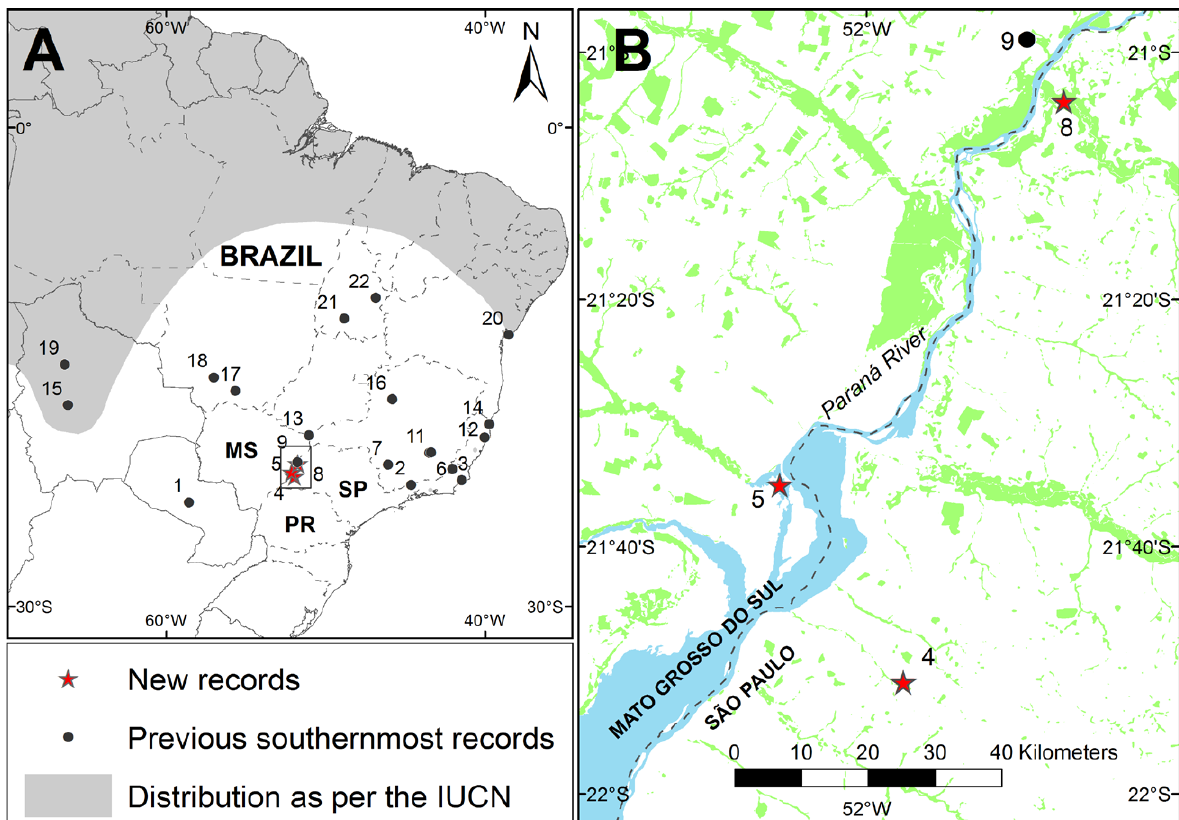
Figure 1. A. Southern part of the distribution of Lophostoma brasiliense , showing the southernmost known records (dots), the new records (stars) presented herein, and part of the International Union for Conservation of Nature (IUCN) polygon for the taxon (Sampaio et al. 2016). MS = Mato Grosso do Sul state, PR = Paraná state, SP = São Paulo state. B. Detail of the area where the new records of L. brasiliense were made. The Paraná River is in light blue and the native vegetation remnants are in light green. Numbers correspond to the localities